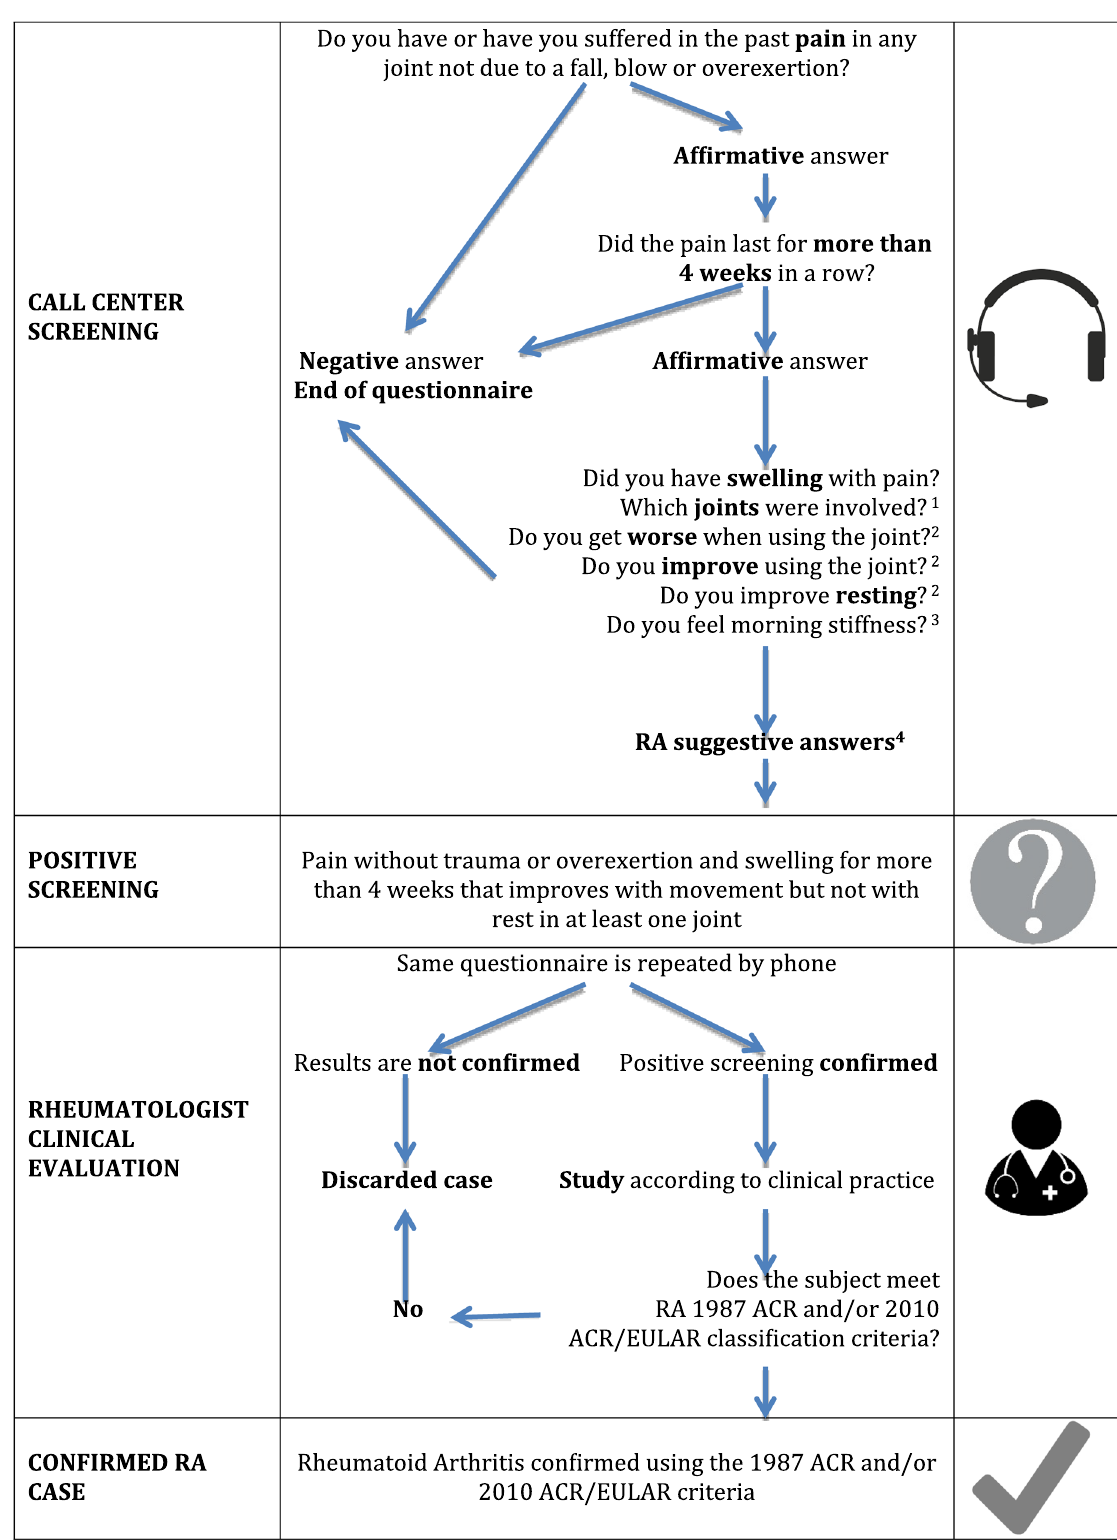
Figure 1. Symptom-based screening flowchart in EPISER2016 for individuals not previously diagnosed with Rheumatoid Arthritis. RA rheumatoid arthritis. 1 Subject was questioned about pain with swelling that lasted more than 4 consecutive weeks in a row without any fall, blow or trauma, particularly in the hands, hips/groins, knees, ankles and feet, specifying if location was on the left side, right side or both. 2 These questions were referred only to the areas previously referred to as painful. 3 In the case of an affirmative answer, there was an additional question consulting if duration was greater than 30 min. 4 Considered suggestive of RA: an affirmative answer to pain improvement with activity, plus a negative answer to improvement with